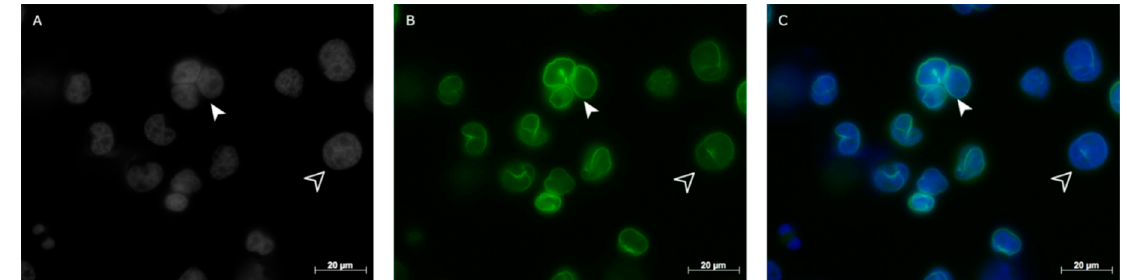
Figure 1. Example of lamin A/C protein staining in cells from Hodgkin’s lymphoma (HDLM-2). ( A ) Two-dimensional (2D) image of nuclei stained with 4 ′ ,6-diamidino-2-phenylindole (DAPI)-(gray scale); ( B ) 2D image of anti-lamin A/C antibody immunostaining (green); ( C ) 2D merged image showing both mono-nuclear H (empty arrowhead) and bi- to multi-nuclear RS cells (solid arrowhead) expressing lamin A/C.